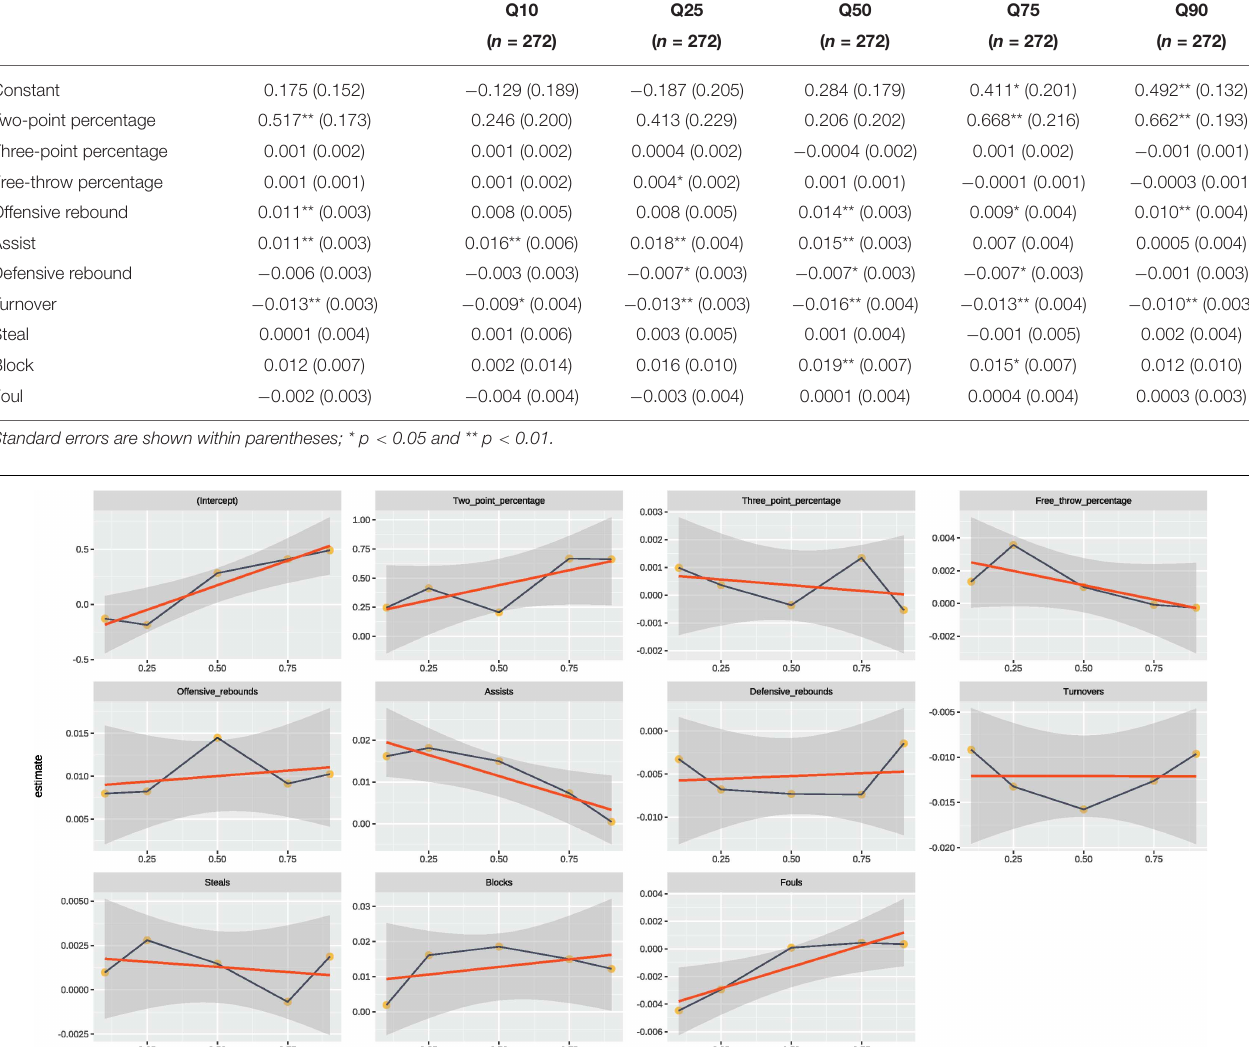
for both models, except for the 25th quantile (RC =